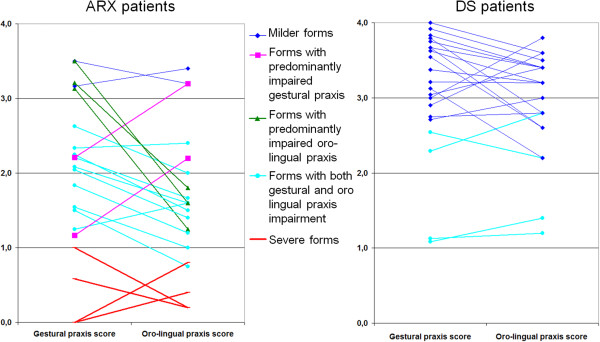
Oro-lingual and gestural scores in 21
ARX
mutated patients compared to 21 age-matched DS patients: 4
ARX
patients (red lines) showed the most severe forms, with global scores below 1 for gestural and oro-lingual praxis; 15
ARX
patients (blue, green and pink lines) had global scores between 1 and 2.5 with respect to oro-lingual and/or gestural praxis; 3 (green) had a predominantly gestural praxis impairment (difference between the two scores of more than 1), and 2 (pink) had a predominantly oro-lingual praxis impairment; the remaining 2 patients (dark blue) exhibited milder forms with scores just above 3.